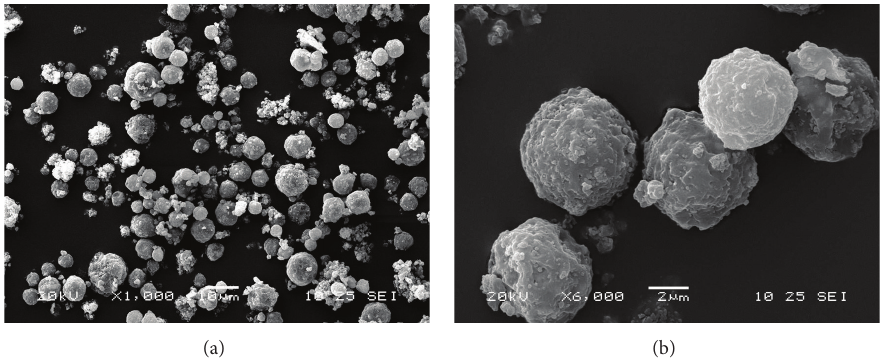
Figure 4: SEM images of CP 1 taken at low (a) and high (b)